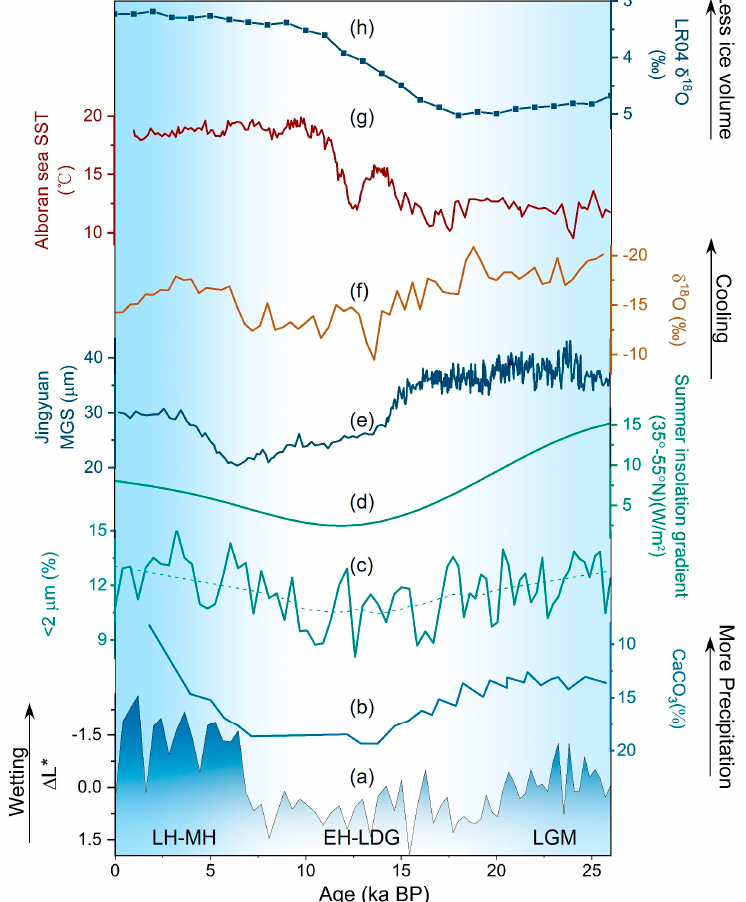
Figure 7. Mechanism of effective moisture evolution in the Ili Basin (( a ). calibration lightness Δ L*; ( b ). CaCO 3 content (%) from loess section XY17 [108]; ( c ). the <2 μ m grain size fraction content (%) from ZSP section [39]; ( d ). summer insolation gradient between 35° N and 55° N [110]; ( e ). mean grain sizes (MGS) of Jingyuan loess in the western Chinese Loess Plateau [98]; ( f ). Guliya ice core δ 18 O record from the Northwestern Tibetan Plateau [111]; ( g ). Alboran sea surface temperature (°C) [112]; ( h ). benthic δ 18 O record [113]).